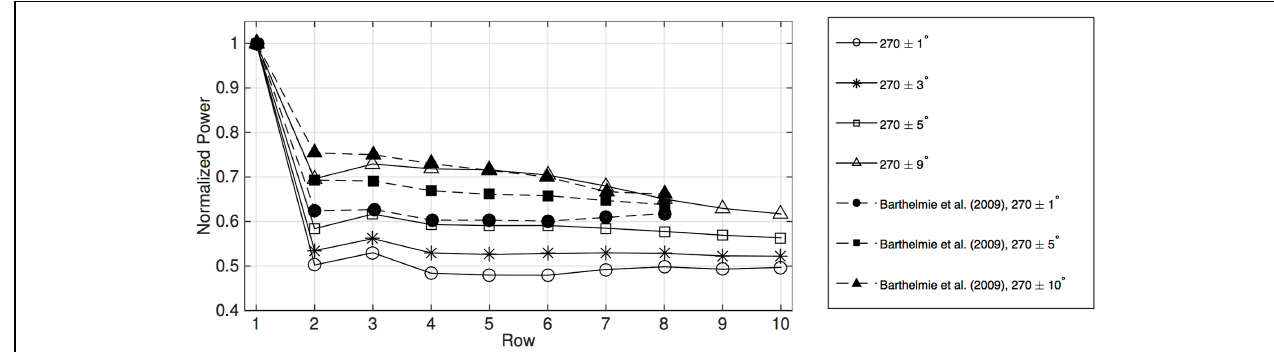
FIGURE 4 | Comparison of the normalized mean power output data obtained from the measurements Barthelmie et al. (2009) and the present simulations, for several wind